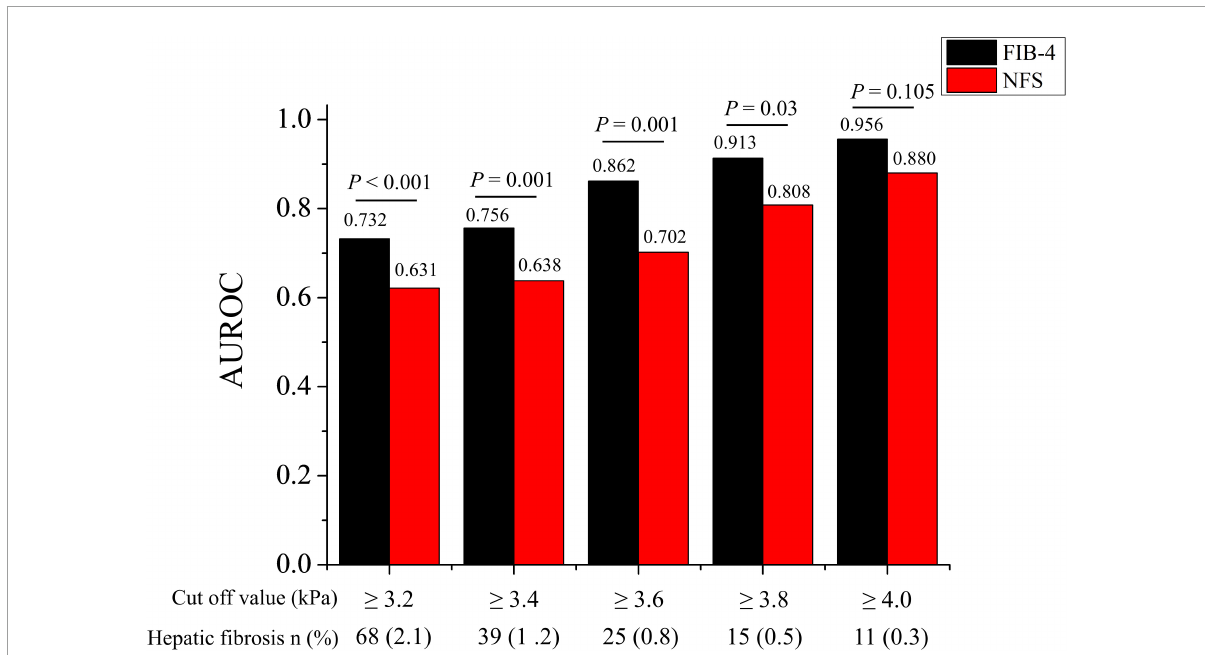
FIGURE4 Comparison of AUROC for advanced hepatic fibrosis between FIB-4 and NFS in the metabolically healthy group at various MRE cut-off values (3.2–4.0 kPa). AUROC, area under the receiver operating characteristic curve; FIB-4, fibrosis-4 index; NFS, NAFLD fibrosis